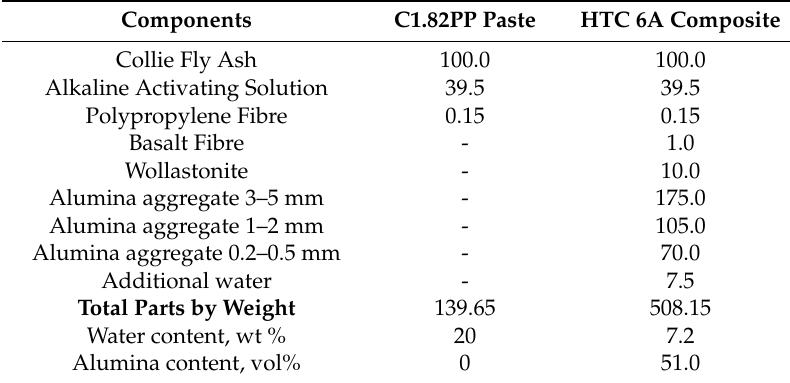
Table 2. Formulations of the two mixtures (parts by weight) with total water content and alumina content at the bottom of the table.